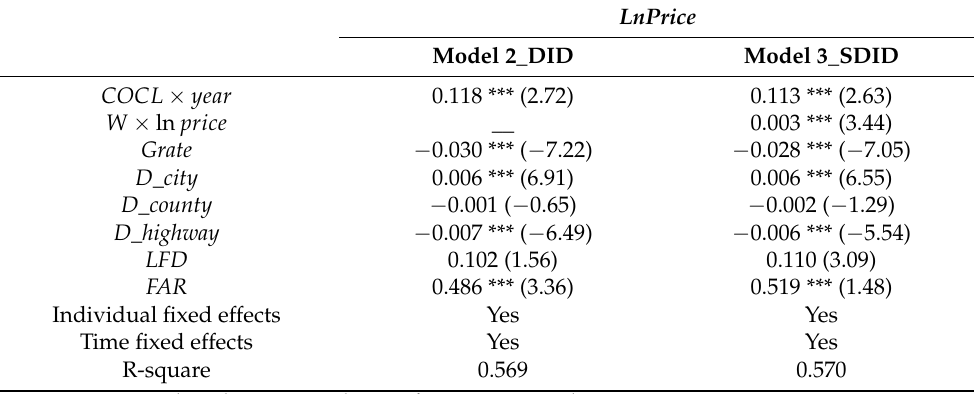
Table 10. Estimations of the effect of COCLEM on SIL price without samples in development